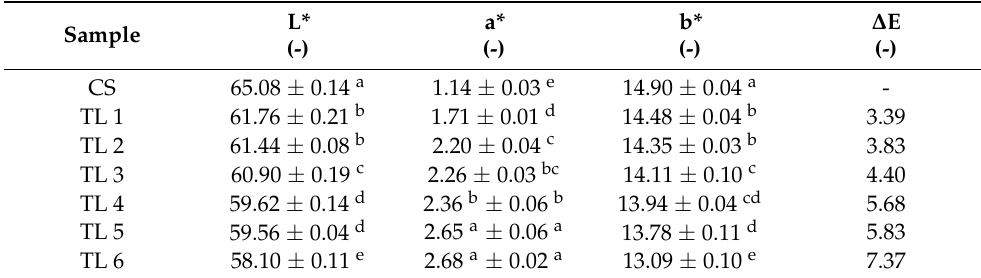
Table 4. Crumb color parameters of bread enriched with Taraxacum officinale